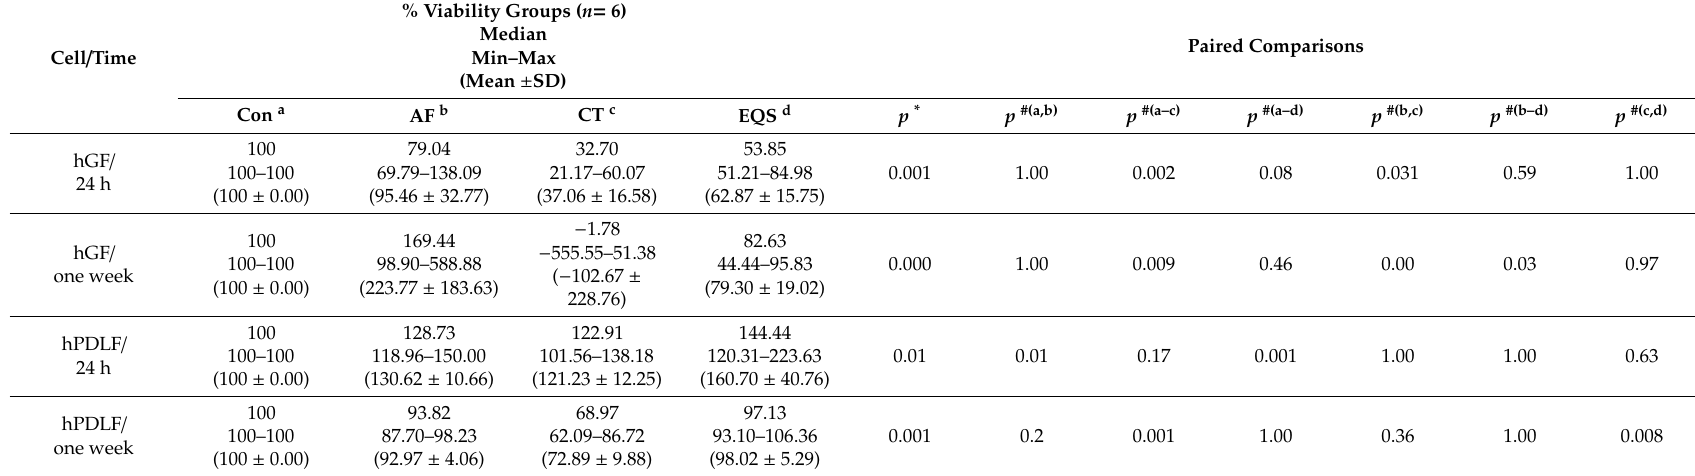
Table 2. Intergroup and paired viability comparisons of CRs on hGF and hPDLF cell lines at 24 h and one week time